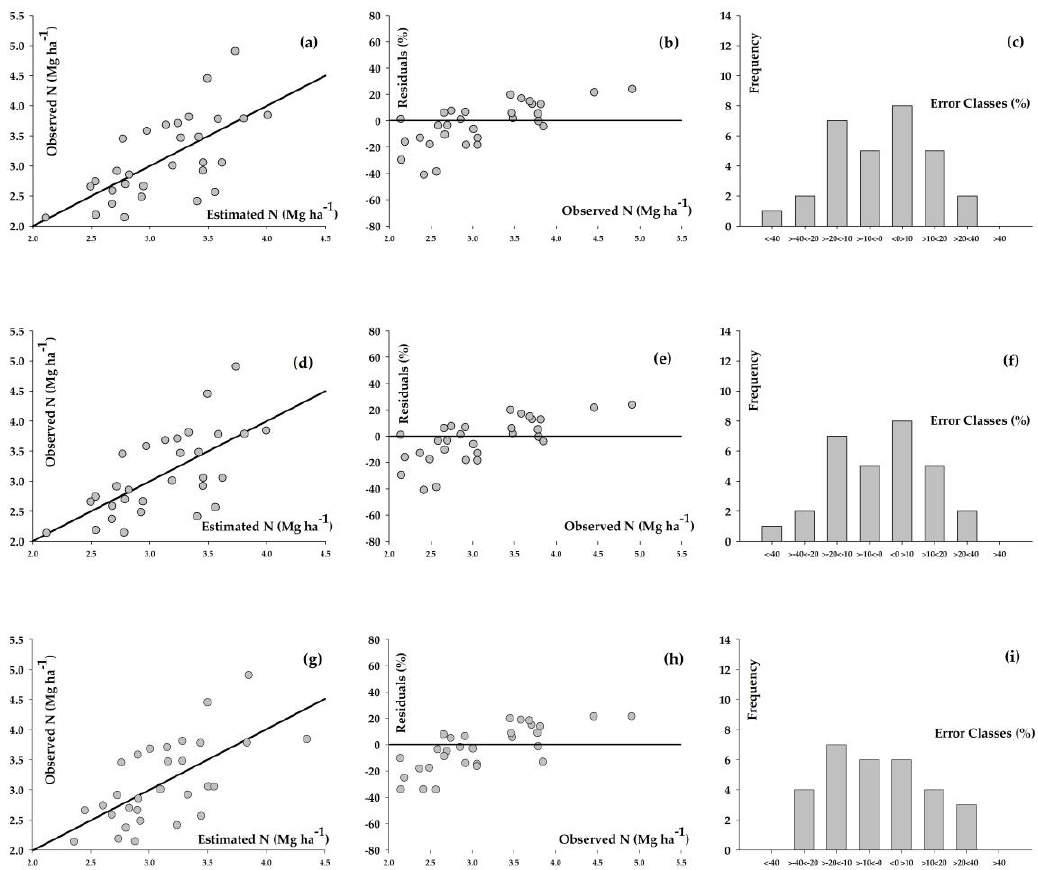
Figure 3. Dispersion of estimated value by observed value, dispersion of residues, and distribution in error classes obtained for the nitrogen adjustments (Mg ha − 1 ) using non-linear models, where ( a – c ) refer to the Richards model, ( d – f ) to the Weibull model, and ( g – i ) to the Schumacher–Hall model. Table 8. Statistical parameters of the non-linear models obtained in the adjustment of the amount of potassium in the eucalypt stand. Table 7. Statistical parameters of the non-linear models obtained in the adjustment of the amount of phosphorus in the eucalypt stand.